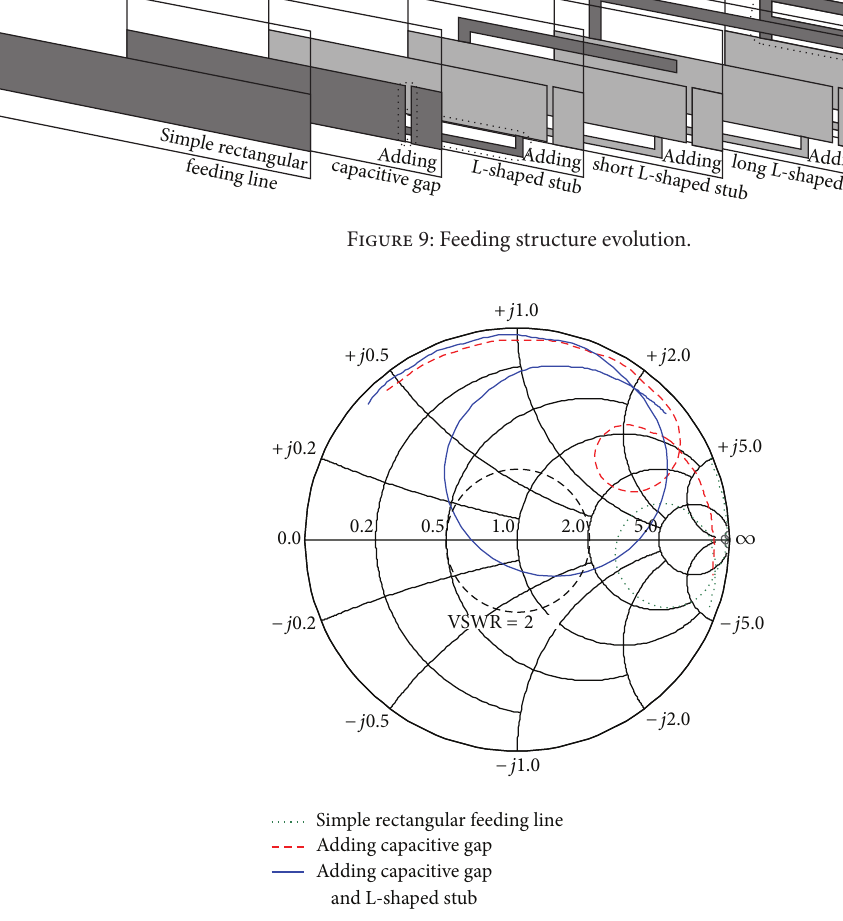
Figure 10: Simulated input impedance characteristics when the gap and L-shaped stub are